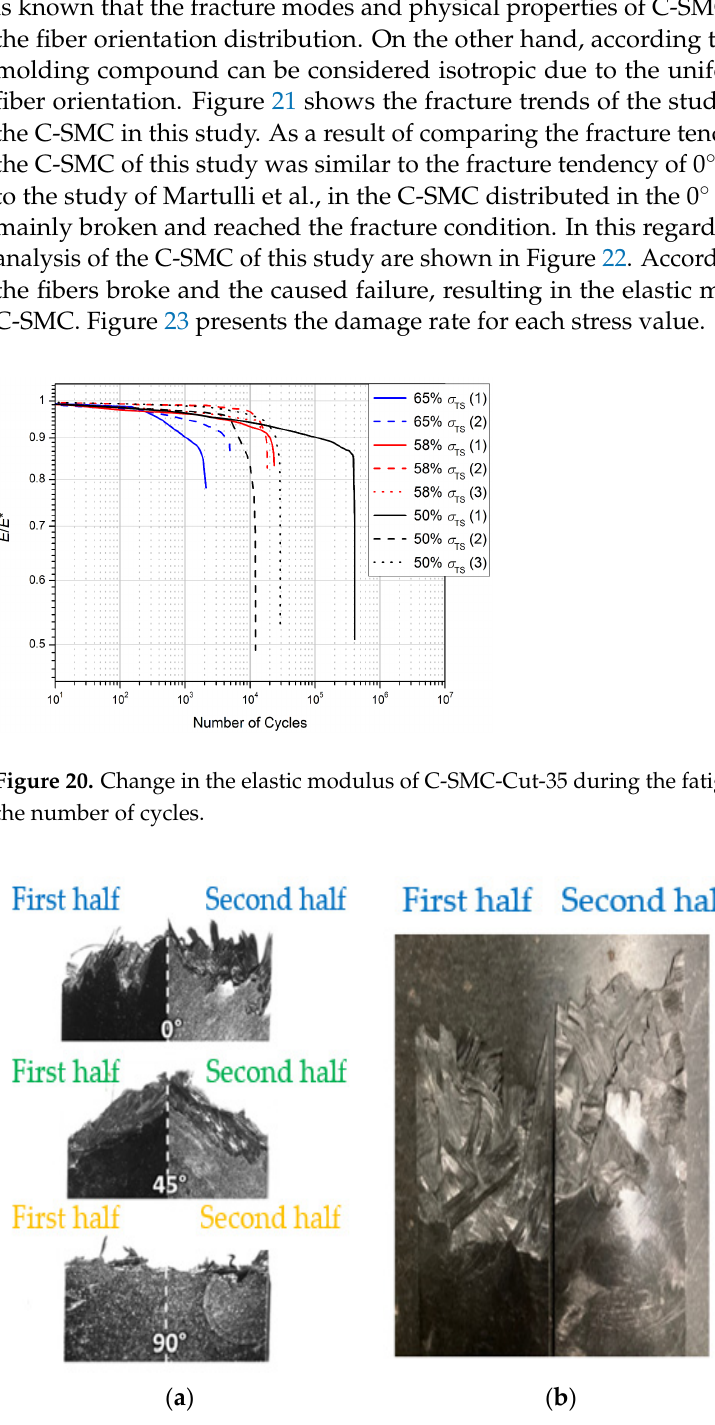
Figure 22. SEM observation of C-SMC.